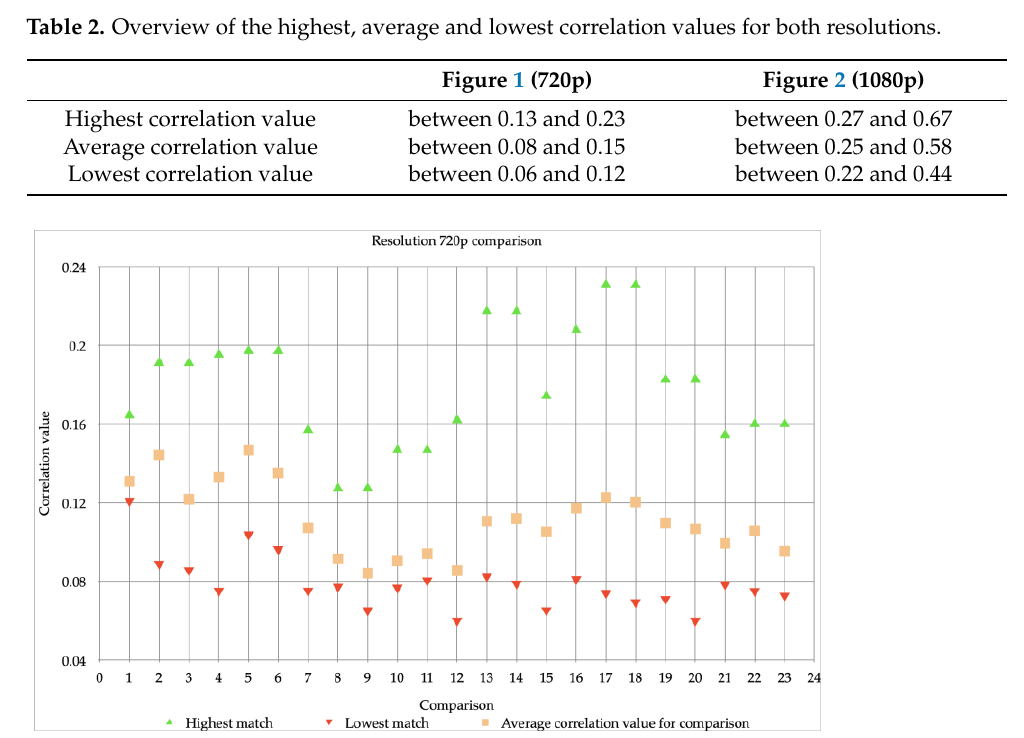
Figure 1. 23 comparisons, done with images made with an iPhone 6, all with a resolution of 720p.